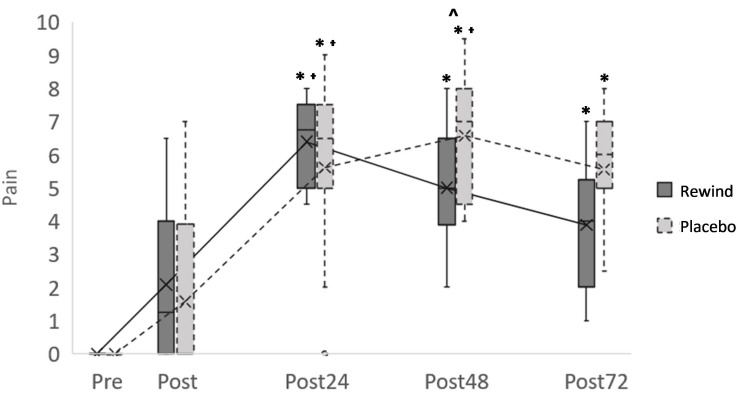
Pain evolution after exercise comparing ReWin(d) and Placebo groups. Significant pain differences (p < 0.007) with respect to T1(∗), with respect to T2(ɫ), and between ReWin(d) and Placebo (∧).